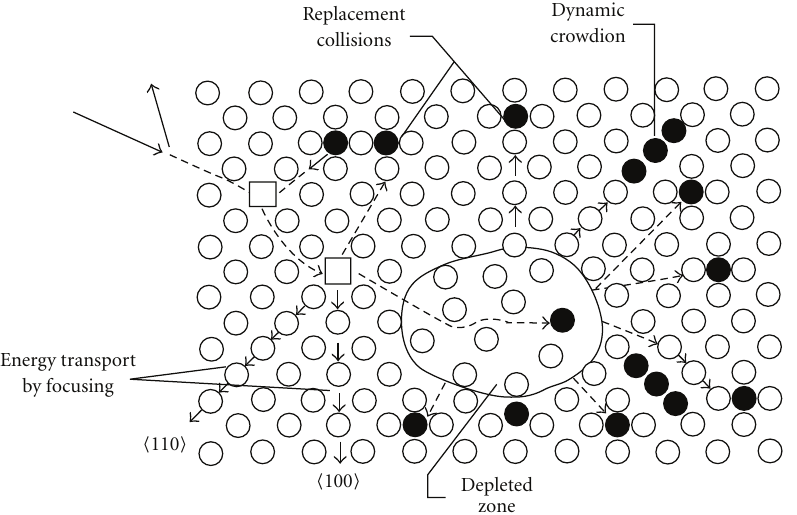
Figure 1: Schematic of neutron damage [1].